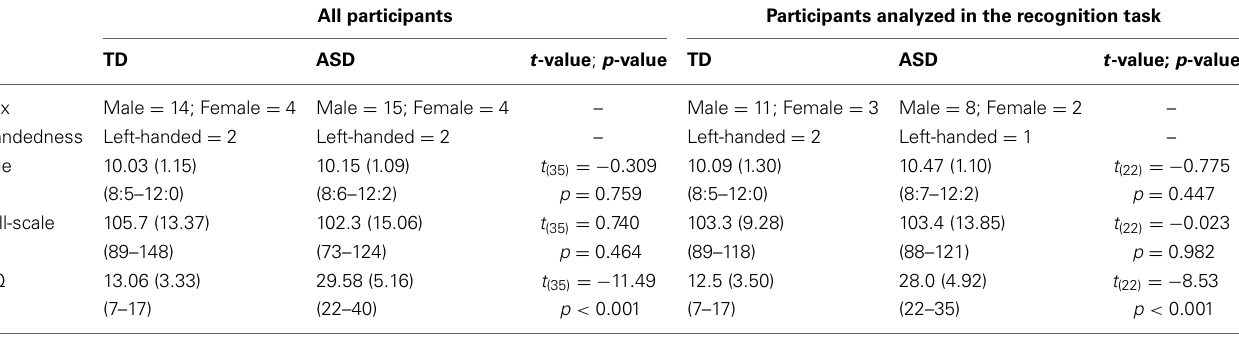
Table 1 | Mean (SD; range) chronological age, IQ scores, and AQ scores from all participants (left column) and from the participants who were included in analysis in the recognition task (right column) for each ASD and TD group. All participants